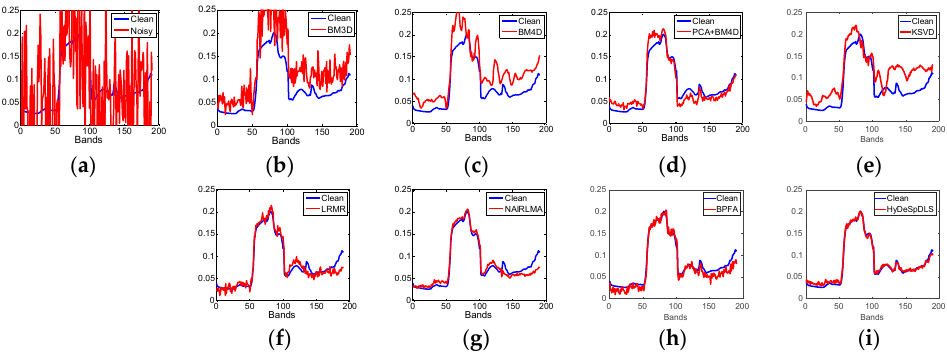
Figure 5. Denoised spectral signature results of Washington DC Mall data with Gaussian i.i.d. noise: ( a ) Noisy; ( b ) BM3D; ( c ) BM4D; ( d ) PCA + BM4D; ( e ) KSVD; ( f ) LRMR; ( g ) NAILRMA; ( h ) BPFA; and ( i ) HyDeSpDLS.